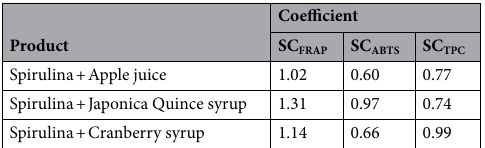
Table 1. Synergy coefficients of spirulina containing